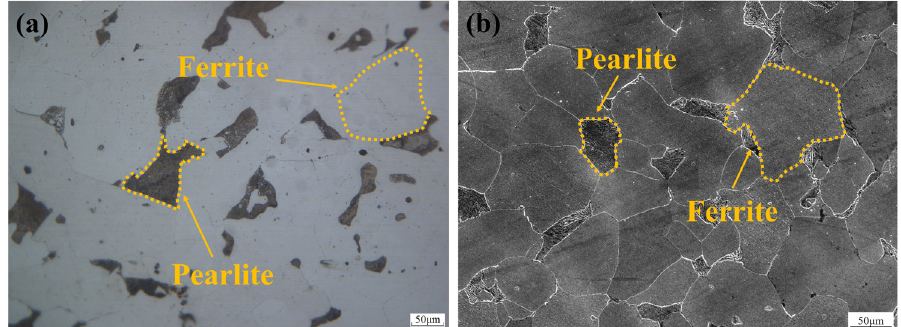
Figure 1: Microstructure of raw materials: ( a ) OM and ( b ) SEM.